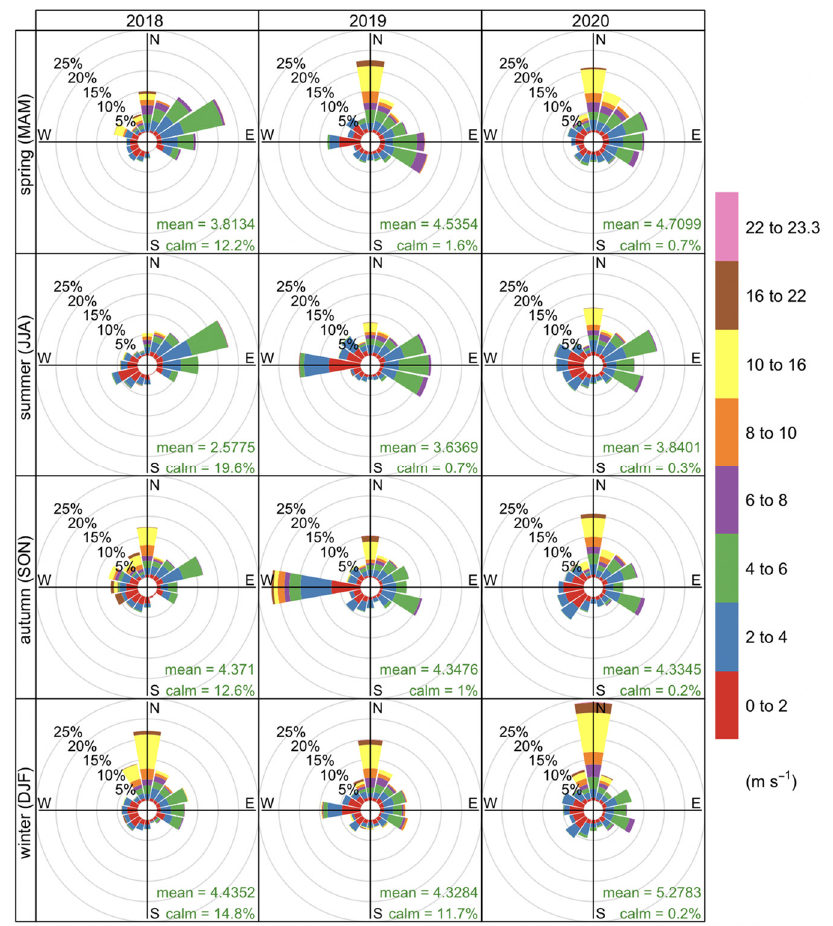
Figure 2. Seasonal wind rose at AQMS, 2018 to 2020.